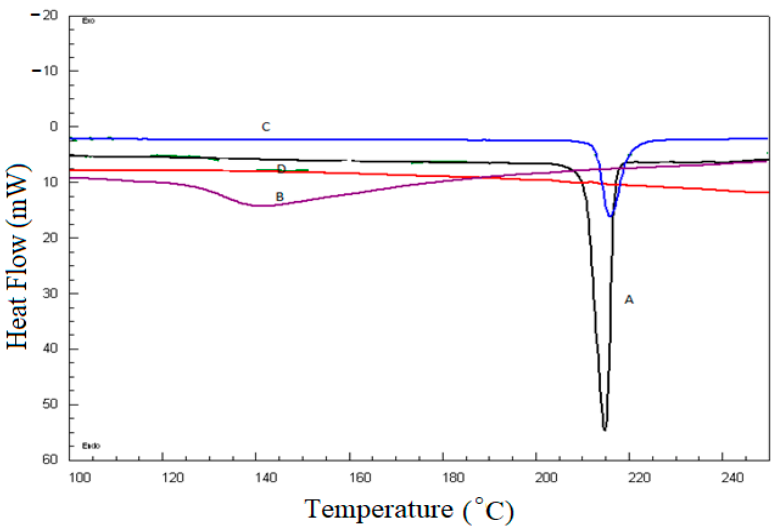
Figure 5. Comparative DSC thermograms; A. pure BGT; B. Span-60, Tween ® 80, and chitosan physical mixture; C. Span-60, Tween ® 80, Chitosan, and BGT physical mixture; D. the optimized formula.